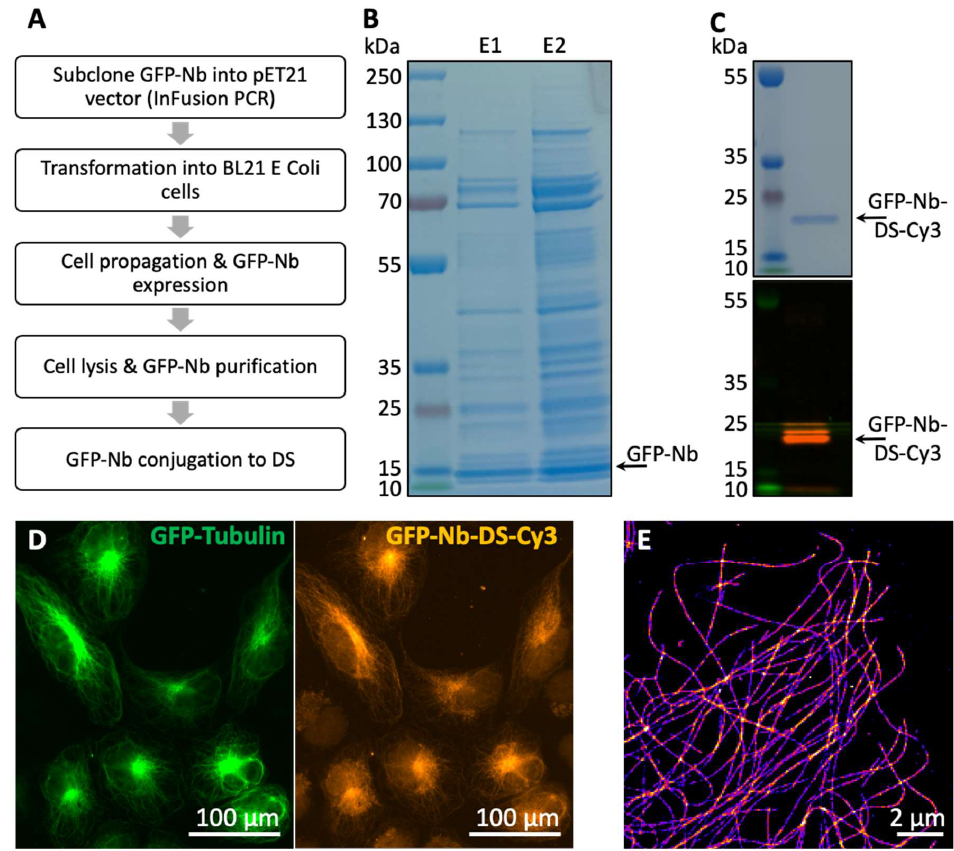
Figure A1. Anti- GFP-nanobody purification and conjugation with DNA oligos. ( A ) Schematic of Figure A1. Anti-GFP-nanobody purification and conjugation with DNA oligos. ( A ) Schematic of GFP-Nb purification workflow. ( B ) SDS-PAGE (NuPAGE Bis-Tris 4–12%) gel of GFP-Nb purified by Ni-chelating chromatography after Coomassie staining. The GFP-Nb was detected at an expected band size of 15 kDa. E1 = first elution and E2 = second elution. ( C ) SDS-PAGE (NuPAGE Bis-Tris 4– 12%) gel of purified GFP-Nb after conjugation to DS labeled with Cy3 via clicking of AzPhe after Coomassie staining (top) and Cy3 in-gel fluorescence (bottom) detected by excitation with green light and filter F595 (for 595 nm). ( D ) Fluorescence images of U2OS cells transiently transfected with GFP-tubulin (green) labeled with GFP-Nb conjugated to DS1-Cy3 (yellow). ( E ) DNA-PAINT image of U2OS cells expressing GFP-tubulin stained with GFP-Nb.